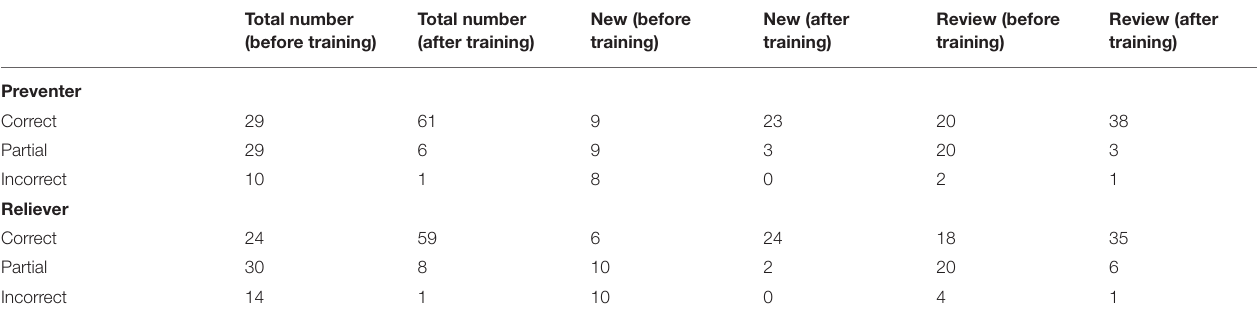
TABLE 3 | For the RBHSC.